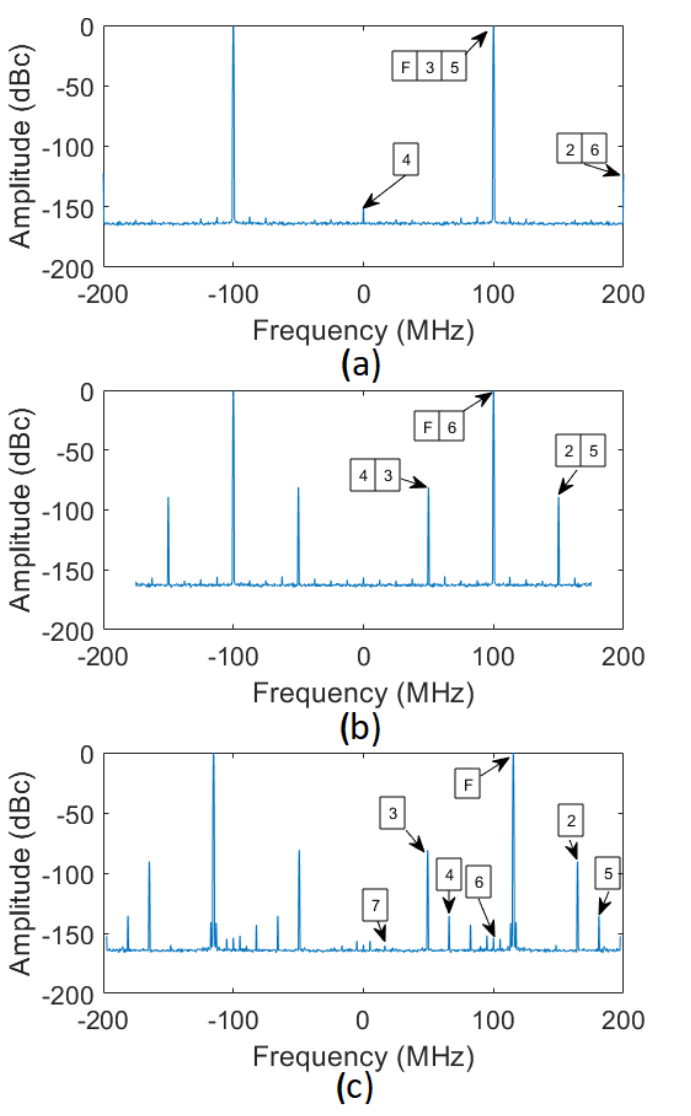
Figure 10. FFT of the of the acquired 1.3 GHz signal before digital demodulation ( a ) sampled at f s = 400 MSa/s (IQ sampling); ( b ) sampled at f s = 350 MSa/s (non-IQ sampling); ( c ) sampled at f s = 394.9367 MSa/s (non-IQ sampling). Labels indicate the harmonic order for each spectral line. Table 2. Rms amplitude stability measured across different bandwidths for different sampling schemes and